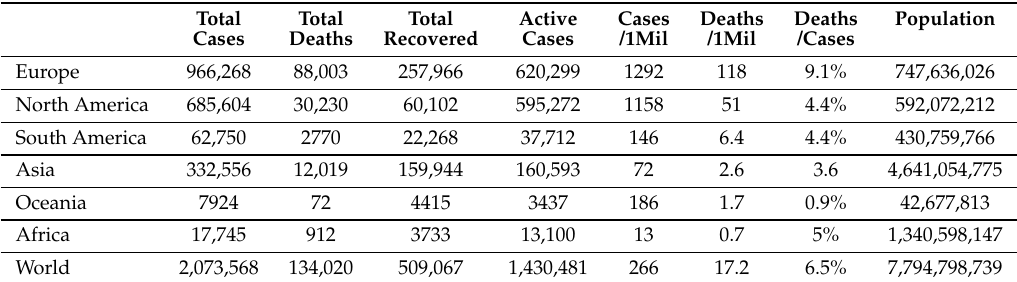
Table 5. World distribution of COVID-19 cases and deaths with relative statistics per million people